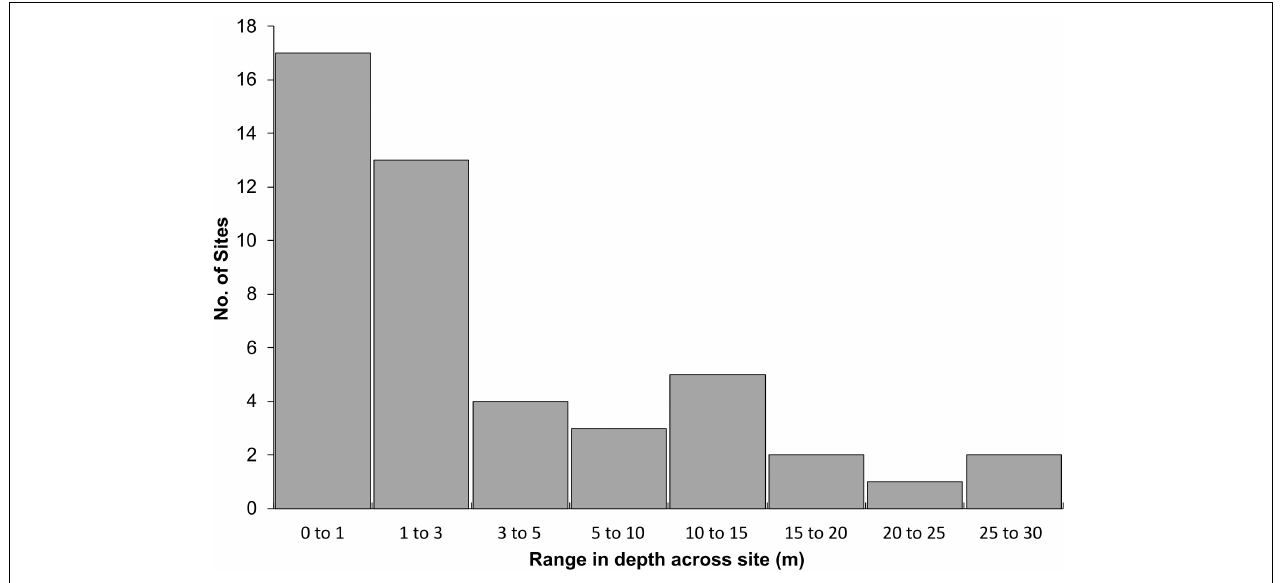
FIGURE 6 | Range in depth from the start to the end of the 100 m transect for 47 of the 56 sites. For 9 of the 56 sites, only a single depth measurement was recorded.